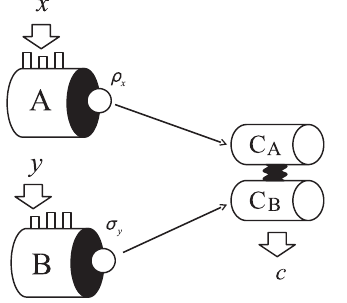
FIG. 4. Picturing the scenario of entangled measurements in bounded Hilbert